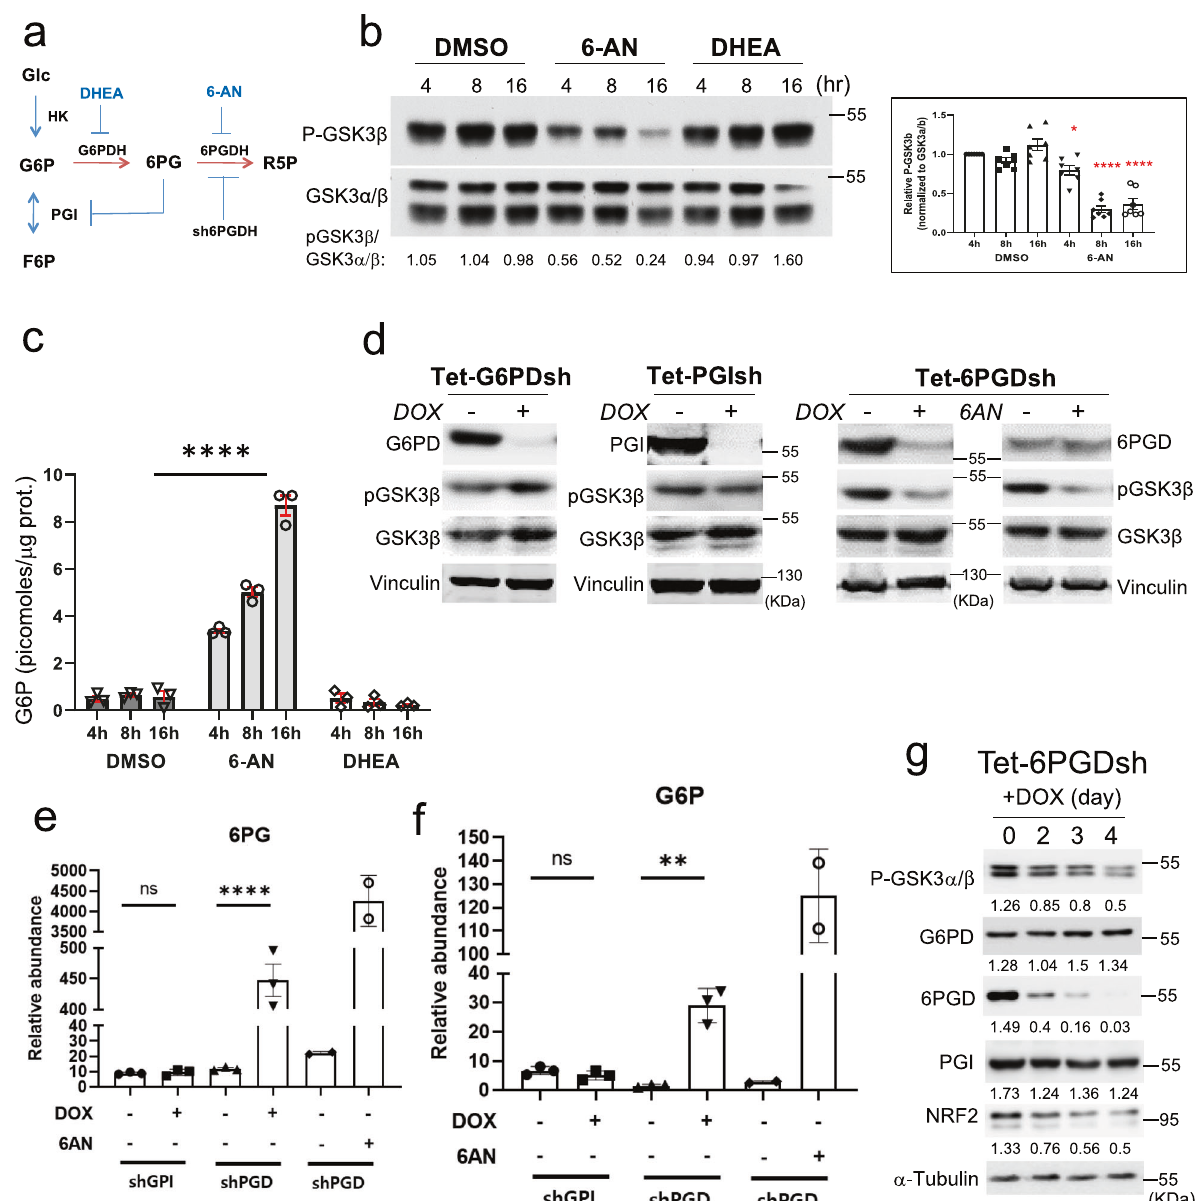
Fig. 5 Evidence that intracellular G6P accumulation inhibits GSK3 phosphorylation. a Schematic showing the effect of DHEA, 6-AN, and the knockdown of 6PGDH on the PPP and glycolysis. b Left panel: Hela cells were treated with either DMSO, 6-AN, or DHEA. At the indicated time points, cells were harvested for immunoblotting using anti-p-GSK3 β and anti-GSK3 α / β . (representative immunoblot is shown). Right panel: quanti fi cations of the effect